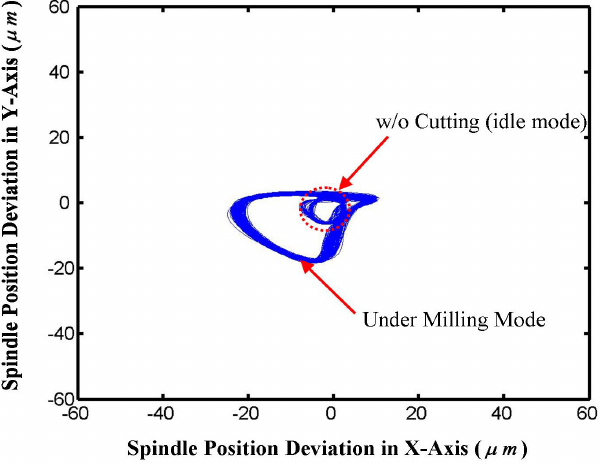
Figure 18. Trajectory of spindle position deviation in X - Y plane (workpiece: aluminum).